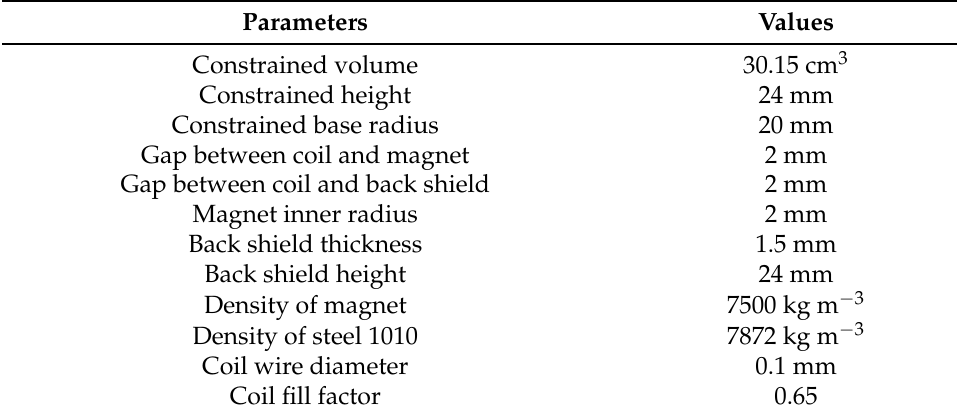
Table 1. Constant parameters of the electromagnetic energy harvester based on dimensions and materials according to [33].